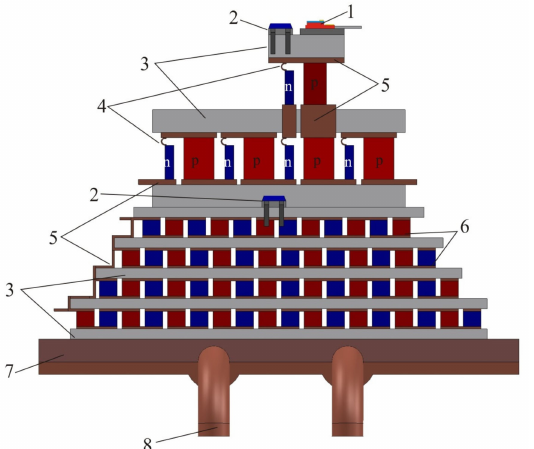
Figure 8. Schematic view of the multistage thermo electric cooler (MTEC). 1—IR detector with the In-doped PbTe p-n junction; 2—platinum thermistors; 3—BeO 2 ceramic; 4—copper foil tape; 5—copper busbars; 6—thermocouples of a multistage thermoelectric module; 7—heat sink; 8—heat